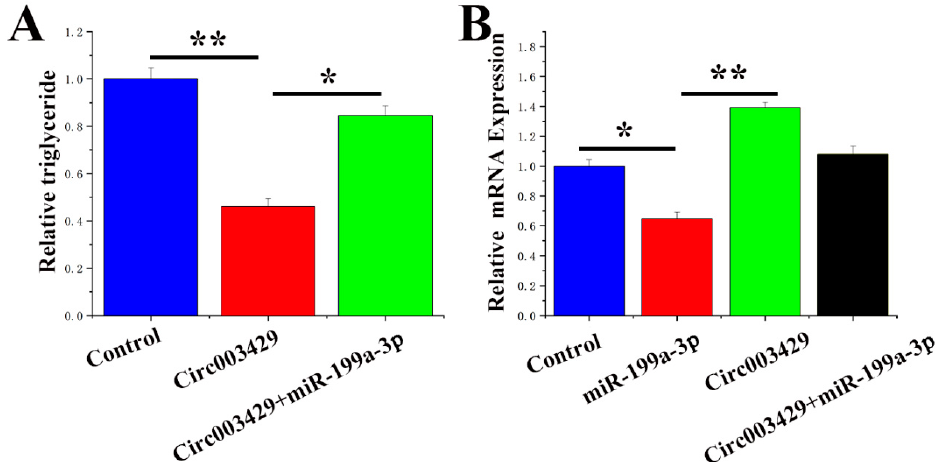
Figure 10. Circ003429 combined with miR-199a-3p relieves YAP1 inhibition. ( A ) TAG levels in cells transfected with control, circ003429, or circ003429 + miR-199a-3p. ( B ) Circ003429 promotes mRNA expression of YAP1 . YAP1 expression levels in cells transfected with control, miR-199a-3p, circ003429 or circ003429 + miR-199a-3p. Values are presented as the means ± standard errors. * p < 0.05; ** p < 0.01.